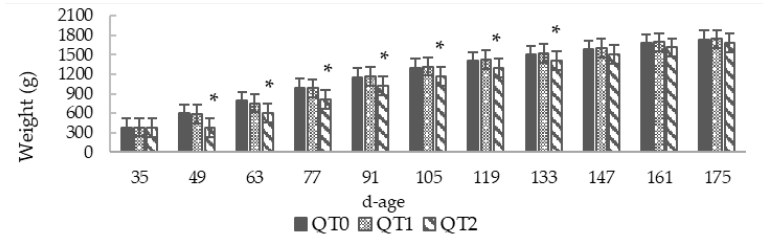
Figure 1. Body weight from birds fed different levels of dietary Quebracho tannin (QT) (mean ± SEM) for a 140-day period starting from 35 days old. * Indicates a difference between treatment and QT0 (Dunnett’s t -test, p < 0.05). QT0 = basal diet; QT1 and QT2 = the basal diet supplemented with QT at 1% and 2%, respectively.